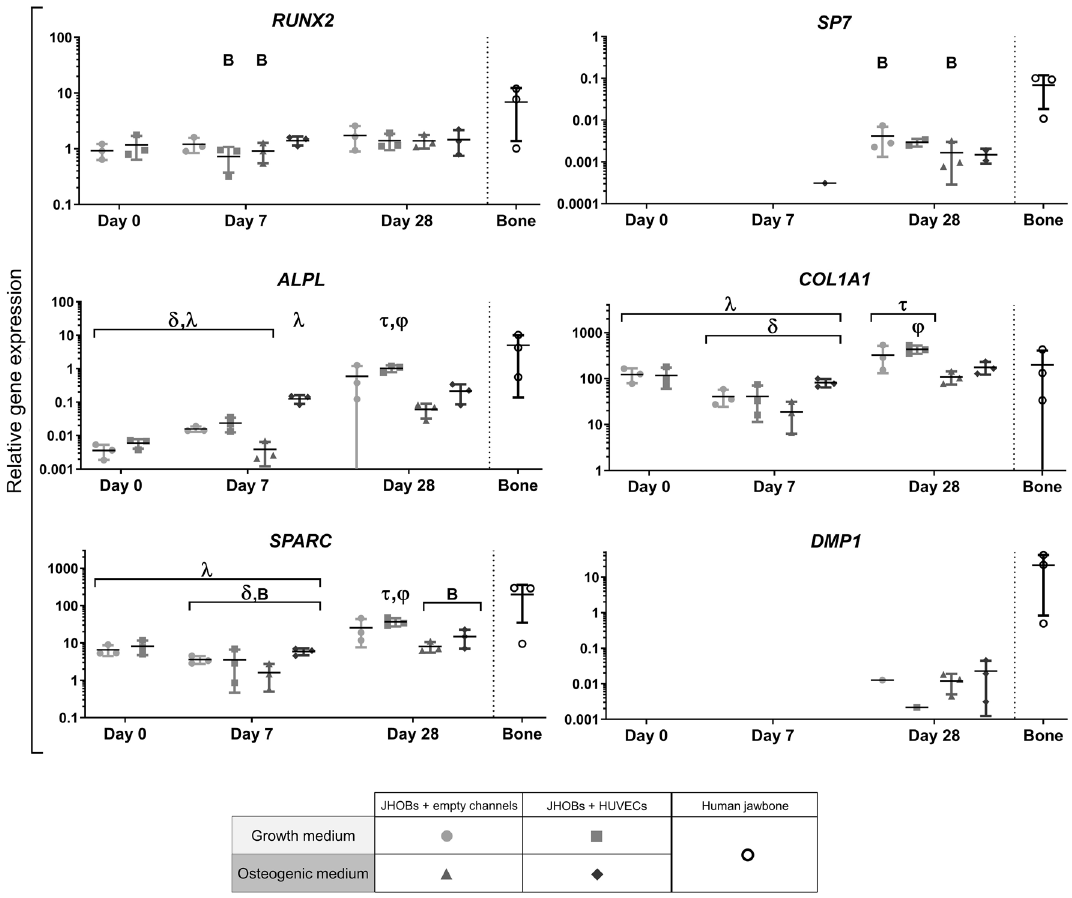
Figure 4. Marker gene expression of the bioprinted human jawbone models. Relative gene expression of the osteoblast differentiation markers RUNX2 (Runt-related transcription factor 2), SP7 (transcription factor Sp7/ osterix), ALPL (alkaline phosphatase), COL1A1 (collagen type I alpha 1 chain), SPARC (osteonectin) and DMP1 (dentin matrix acidic phosphoprotein 1) in cell-laden constructs containing JHOBs and optionally also HUVECs after 0, 7 and 28 days of cultivation in growth and osteogenic medium. Native human jawbone was used as a control. Expression was normalized to UBE2D2 expression. B = data significantly different to native human jawbone (P < 0.05). δ = data significantly different to JHOBs + empty channels in growth medium on day 28. λ = data significantly different to JHOBs + HUVECs in growth medium on day 28. τ = data